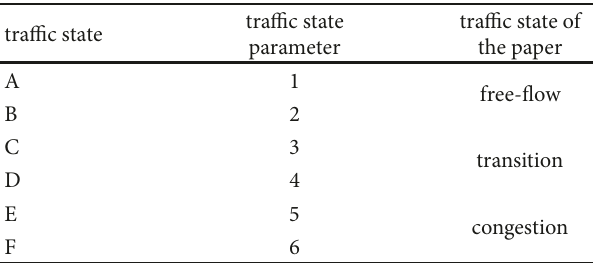
Table 3: The table of traffic state